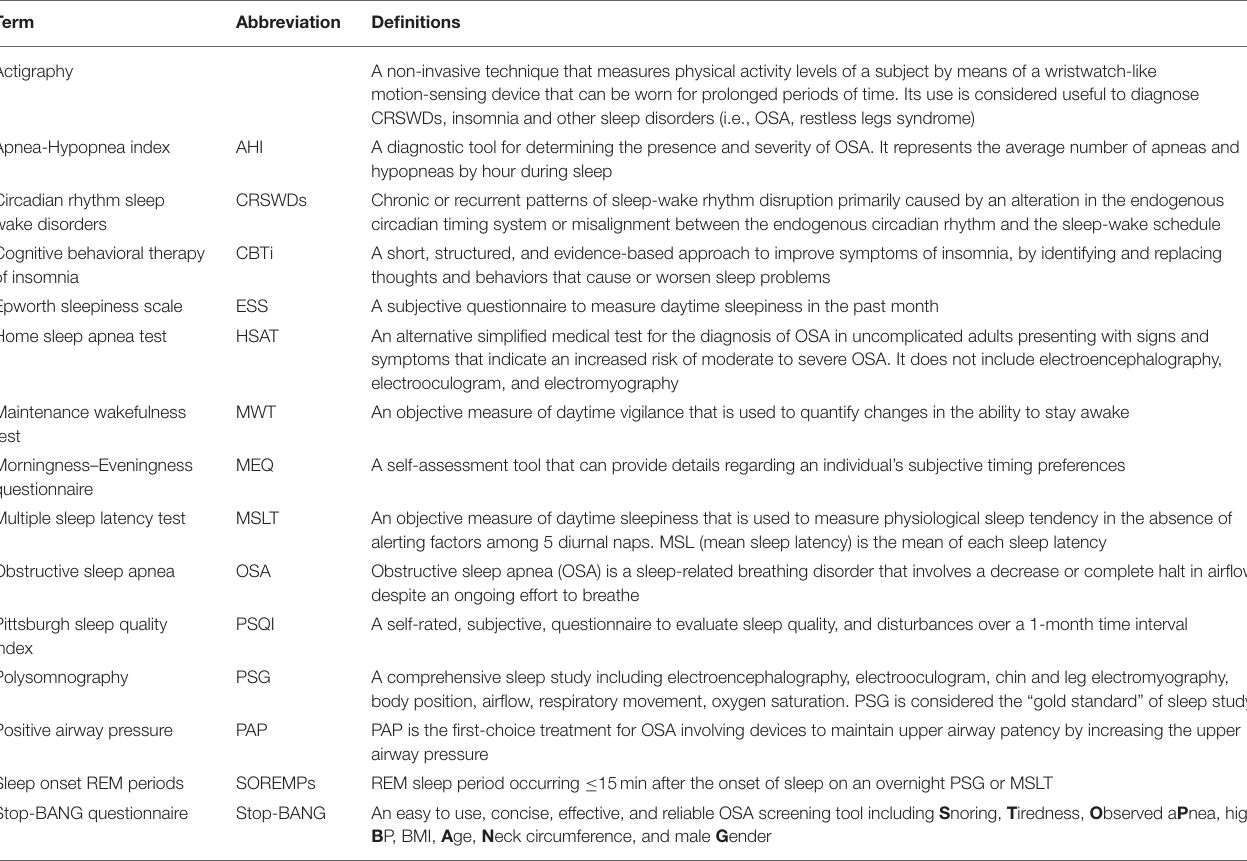
TABLE 4 | Glossary of sleep terms included in the